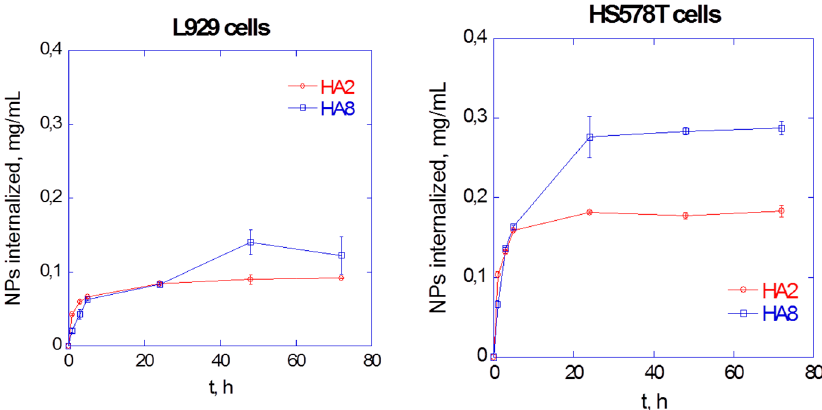
Figure 16. Uptake kinetics of HA2 and HA8 NPs.